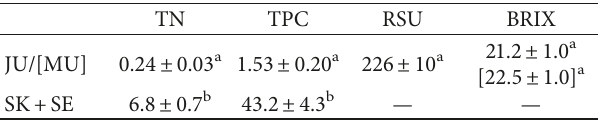
— — TN, total nitrogen expressed as gN/kg; TPC, total protein content expressed as gALA/kg (alanine equivalent); RSU, reducing sugars expressed as